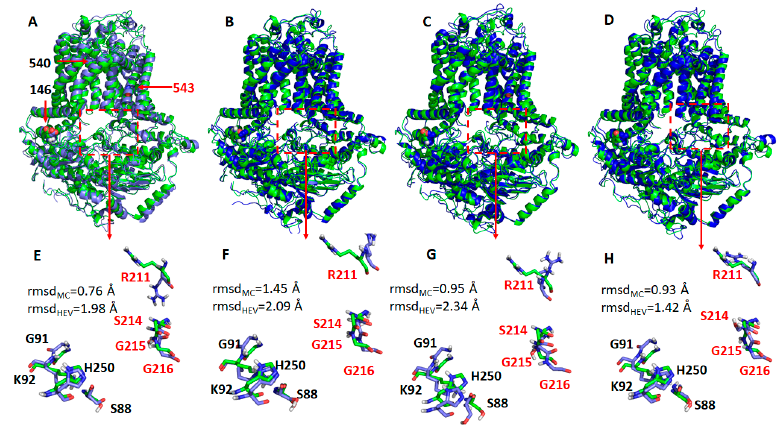
Figure 8. Representative structures of the WT ABCG5/G8 and its three missense mutants. The representative structures (shown as blue cartoons and bluish sticks) were aligned to the crystal structure (green cartoons, and greenish lines). The three mutation residues, E146Q, A540F, and R543S, are shown as spheres. The hypothetical surrounding residues of ATP are shown as dashed rectangles. ( A , E ) Wild type; ( B , F ) E146Q; ( C , G ) A540F; ( D , H ) R543S. G5: ABCG5; G8: ABCG8. Residues in G5 and G8 are separately colored in black and red. Root-mean-square deviations (RMSDs) for the main-chain atoms (rmsd MC ) and all heavy atoms (rmsd HEV ) are shown in the lower panels. If R211 is omitted from RMSD calculations, RMSDs of the main-chain atoms are 0.69, 1.30, 0.88, and 0.78 Å for WT, E146Q, A540, and R543S, respectively; the corresponding RMSDs of heavy atoms are 0.85, 1.42, 1.13, and 0.96 Å.